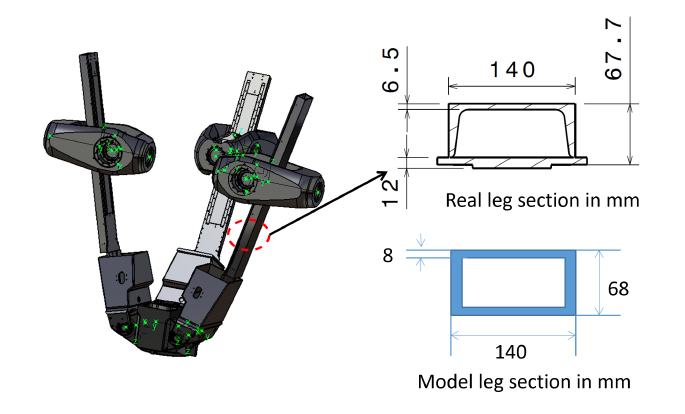
Figure 9. CAD model of the Tripteor X7 PKM and cross-section of its first leg. To compute the Cartesian stiffness matrix of the robot at point O m , the issue is to compute matrix L XI (Equation (29)). Finally, we can compute the stiffness map at a level z = 1.18 m for example (Figure 10).